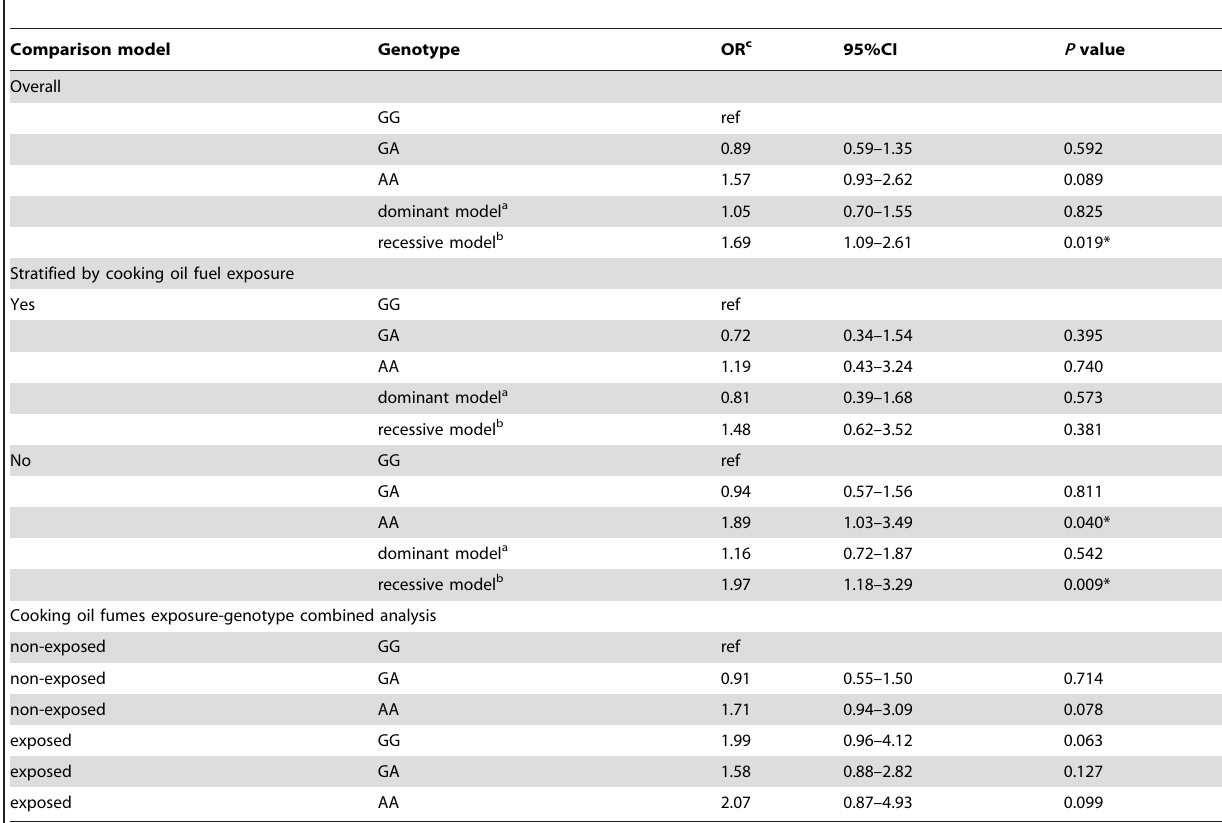
Table 4. Overall association, stratification analysis and combined analysis between ATM rs189037 polymorphism and lung adenocarcinoma